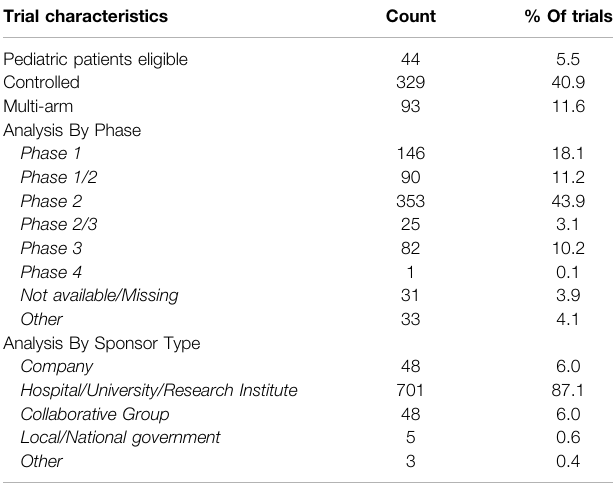
TABLE 1 | Summary statistics of ReDO_Trials_DB trials. Trial characteristics